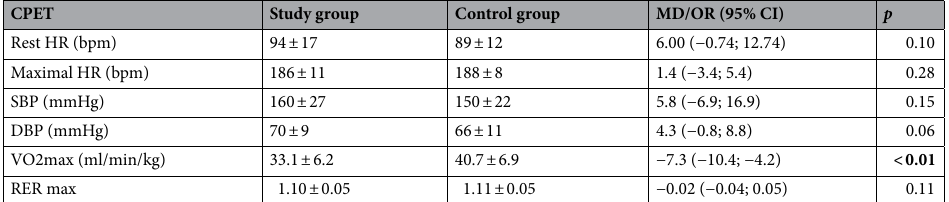
Table 4. CPET parameters in the study and the control group. Significant value is in bold. OR odds ratios, MD mean/median differences, HR heart rate, SBP systolic blood pressure, DBP diastolic blood pressure, VO2 oxygen uptake, O2P oxygen pulse, RER the respiratory exchange ratio.